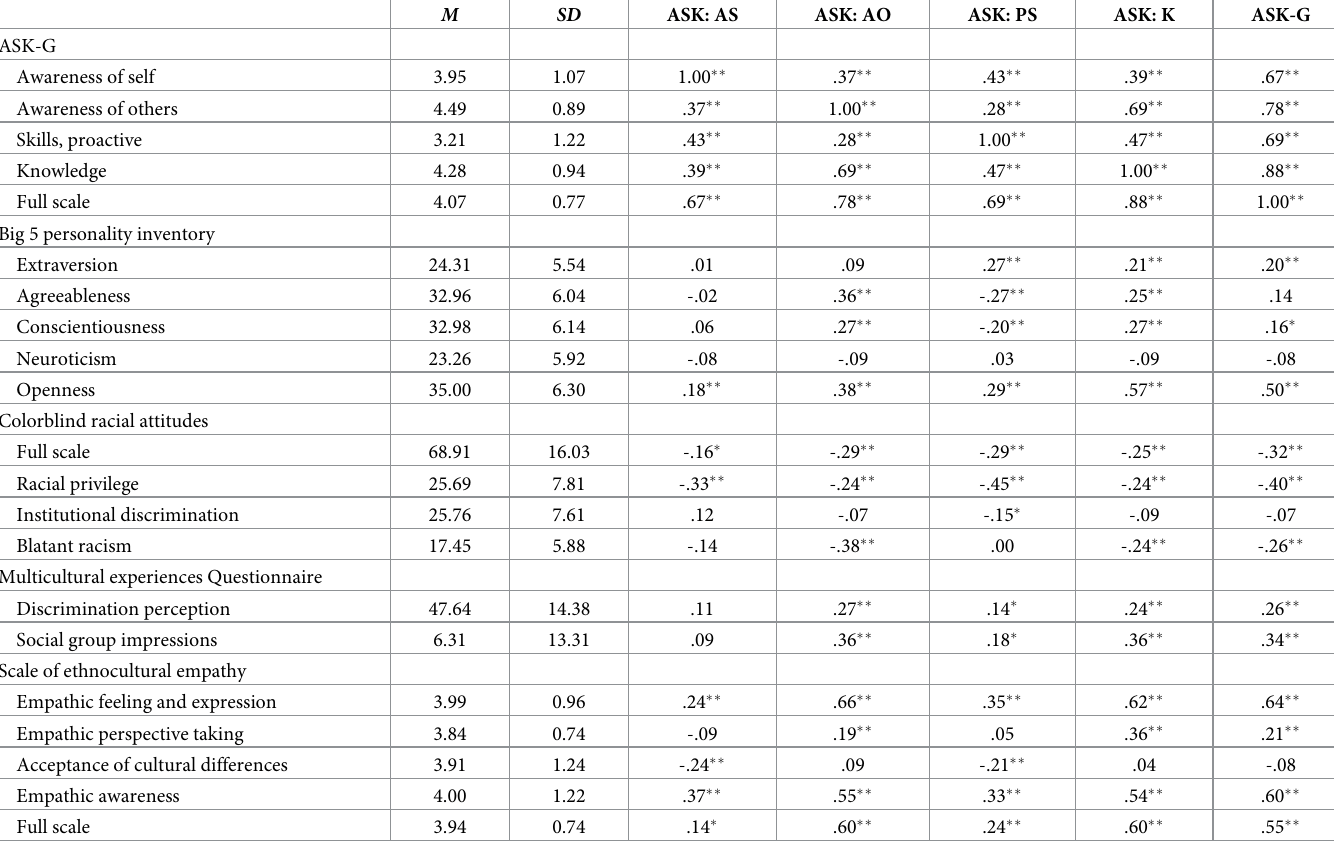
Table 5. Means, standard deviations of scales and correlation with ASK-G